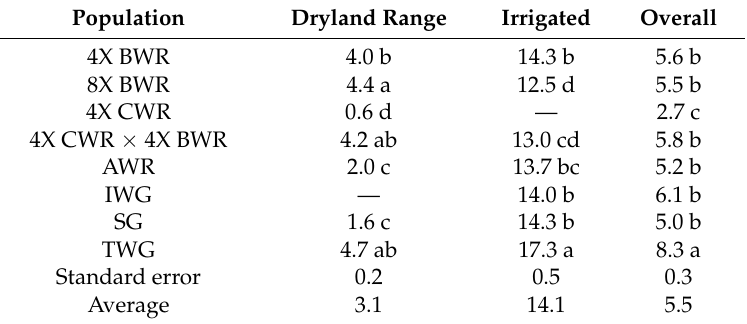
Table 5. Dry matter yield estimates for tetraploid (4X) and octoploid (8X) forms of basin wildrye (BWR), creeping wildrye (CWR), CWR × BWR hybrids, Altai wildyre (AWR), intermediate wheatgrass (IWG), switchgrass (SG), and tall wheatgrass (TWG) across four dryland ranges and one irrigated testing environment. Significant differences among groups of entry means are indicated by lettered ranks based on least significant